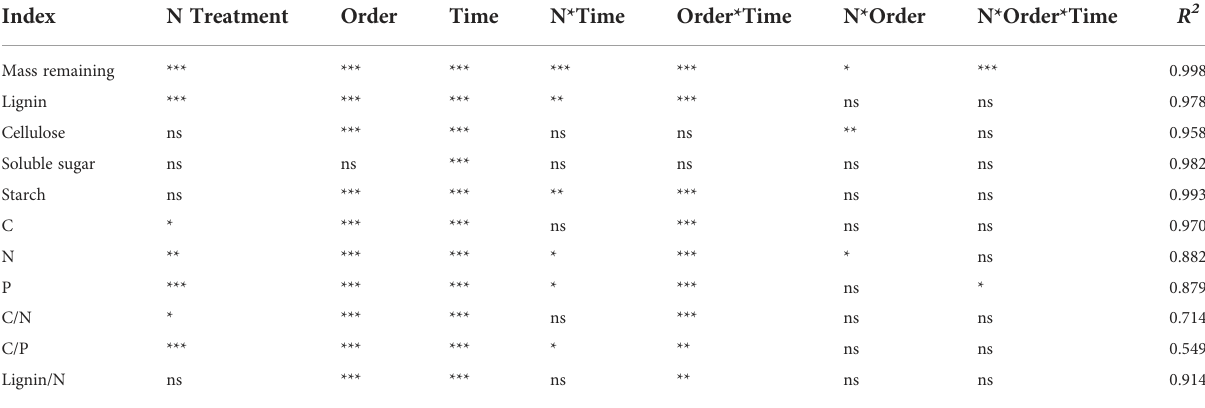
TABLE 3 Effects of N treatment, root order, decomposition time and their interaction on the residual rate of fi ne root decomposition. Index